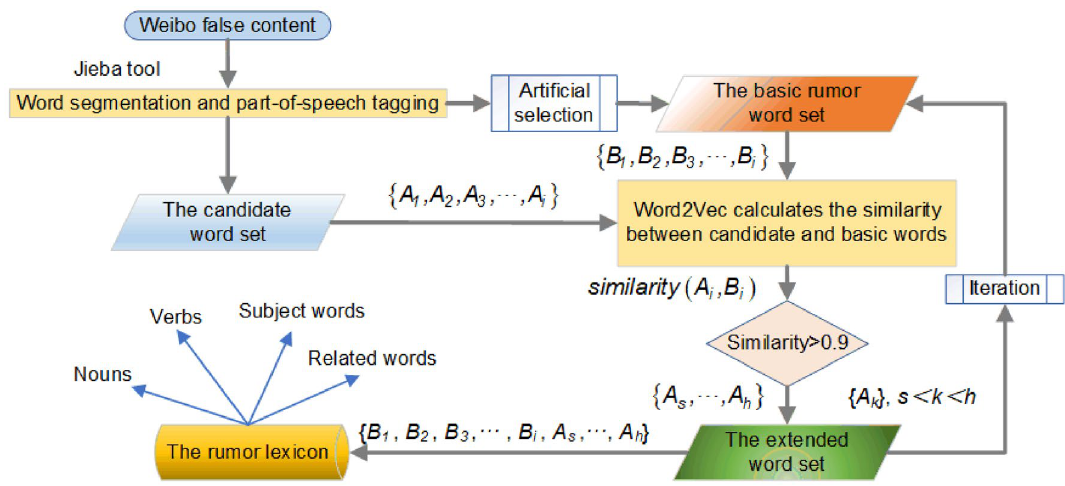
Figure 2. Flowchart of microblog rumor word database